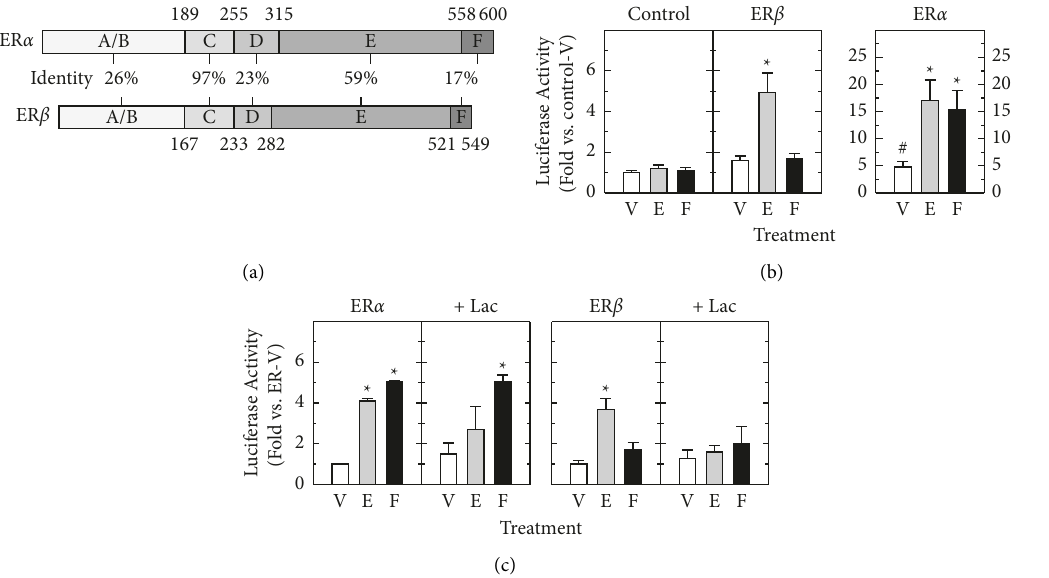
Figure 1: Forskolin increases ER α -, but not ER β -mediated transcription, and forskolin stimulation of ER α transactivation does not require the proteasome pathway. (a) The panel shows the domain organization and sequence homology of rat ER α and ER β . (b) HT22 cells were transiently transfected with pGL3-2ERE luciferase reporter (500ng) plus a control (pcDNA3.1), rat ER α , or ER β expression vector (10ng). These cells received the treatment of either vehicle (V), estradiol (E, 10nM), or forskolin (F, 1 μ M) for 24 h. Luciferase activity (mean ± SEM) was normalized and expressed as fold stimulation over the vehicle-treated controls (as 1 fold) from at least three independent experiments with triplicate samples. ∗ , P < 0 . 05 vs. vehicle-treated groups (V) with the same ER expression vector. # , P < 0 . 05 vs. vehicle-treated group with the empty expression vector (Control-V). (c) HT22 cells, transfected with pGL3-2ERE luciferase reporter plasmid (500 ng) plus a rat ER α or ER β expression vector (10ng), were pretreated with either vehicle or lactacystin (+Lac, 1 μ M), followed by vehicle (V), estradiol (E), or forskolin (F). Normalized luciferase data were expressed as the fold stimulation over vehicle-treated cells carrying the same ER construct (without lactacystin) (1 fold) and expressed as the mean ± SEM from three independent experiments performed in triplicate. ∗ , P < 0 . 05 vs. vehicle-treated groups (V) with the same ER expression vector (without